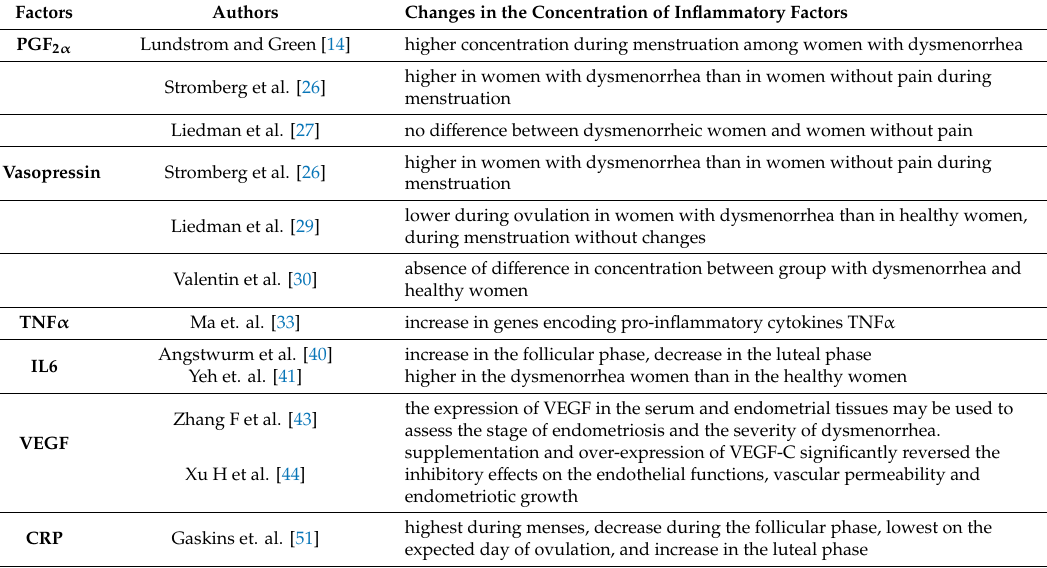
Table 1. Changes in the concentration of inflammatory factors during menstrual